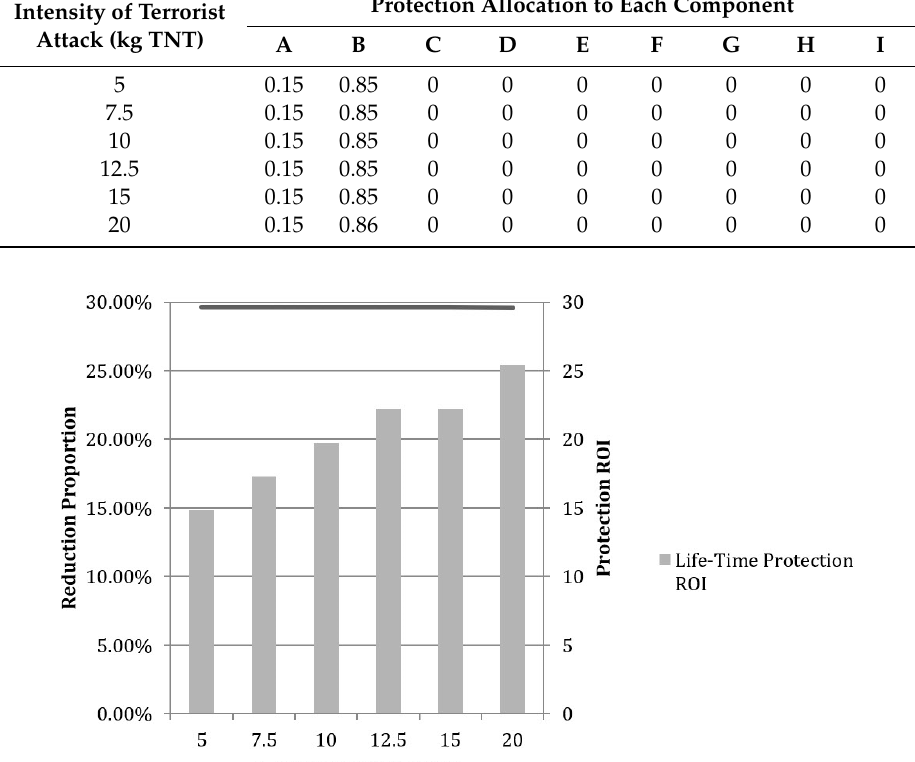
Table 7. Robustness Improvement Strategy for Varied Attacking Scenarios (Protection Level V).